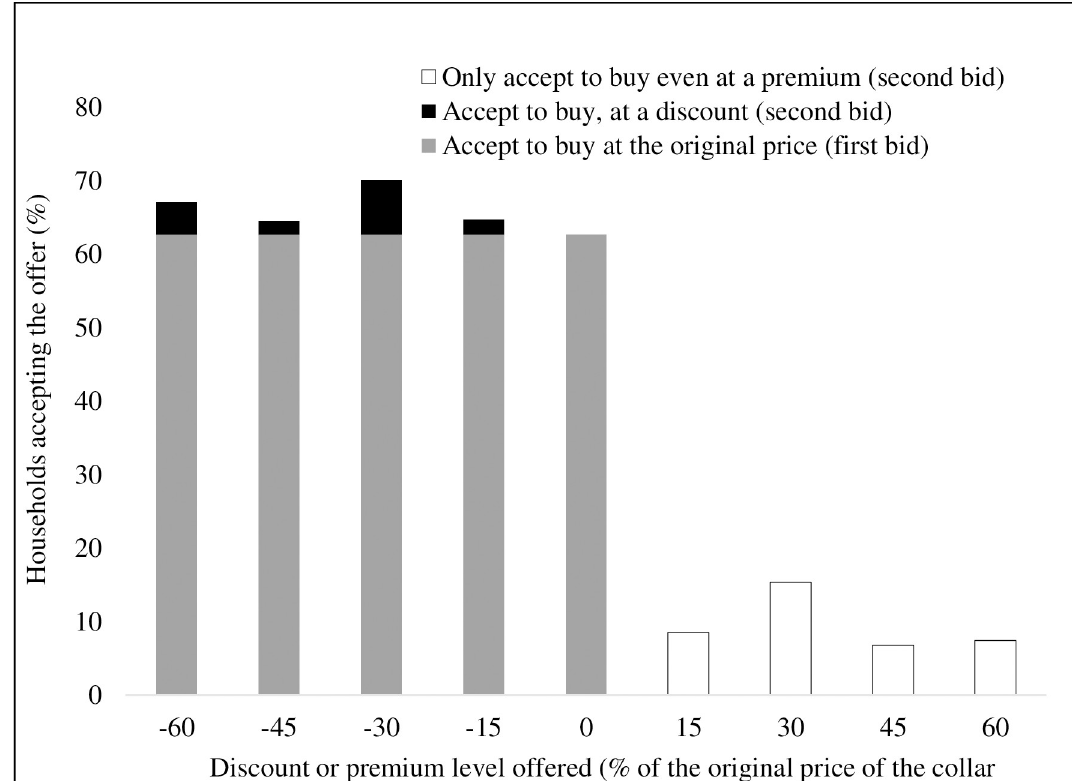
Fig 3. Willingness to pay for the icipe tsetse fly repellent collar in Kwale County.